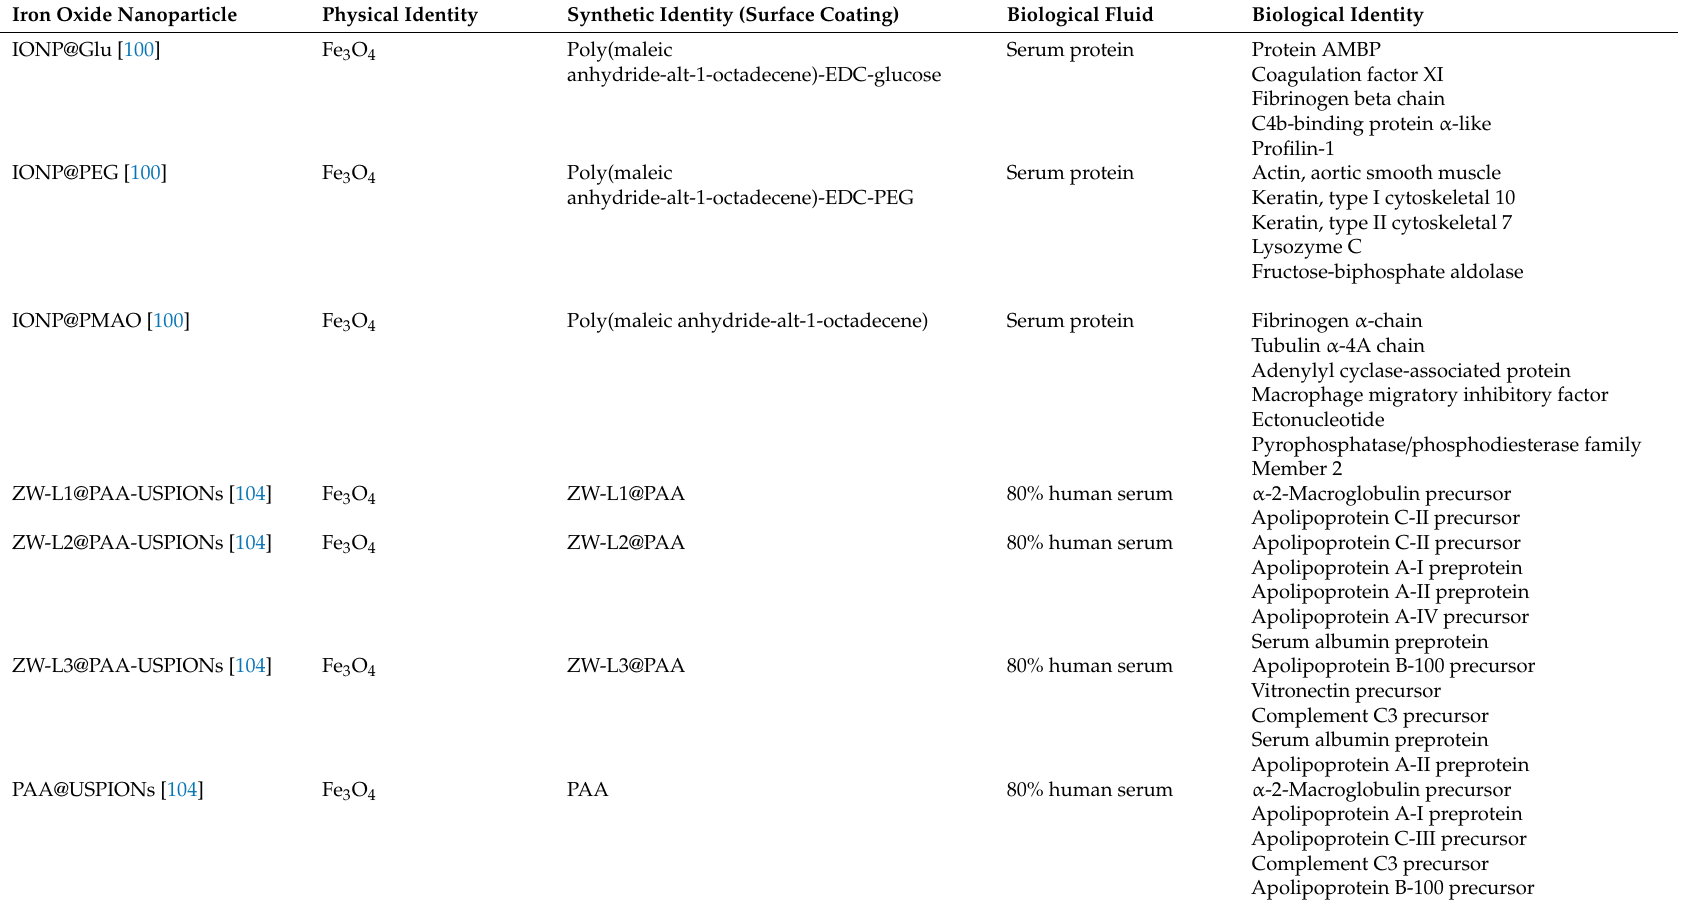
Table 2. List of some of the IONPs investigated for their protein corona composition. Only significantly enriched proteins are